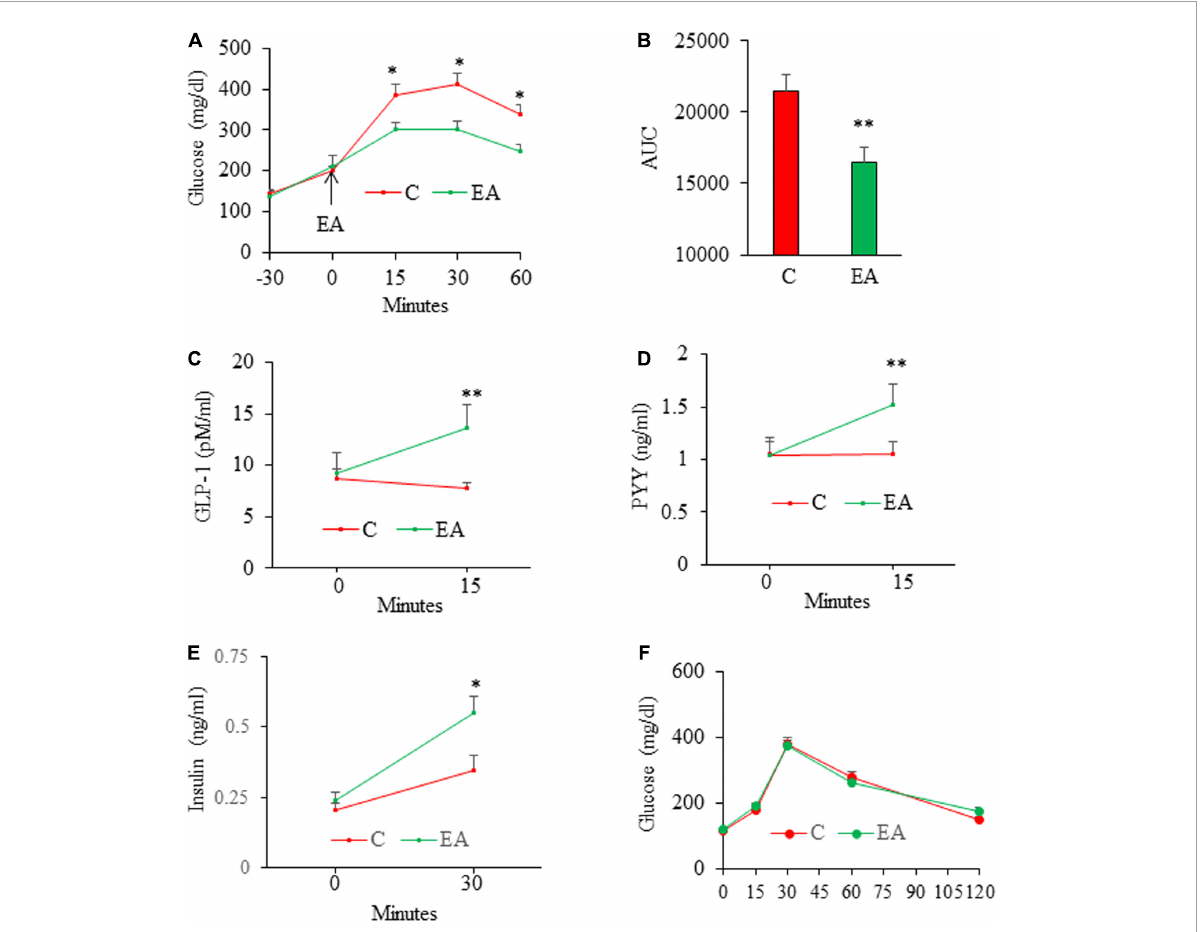
FIGURE3 Acute effects of elenolic acid (EA) on glucose tolerance, glucagon-like peptide-1 (GLP-1), peptide YY (PYY), and insulin secretion in mice. C57BL6 male mice (8 weeks old) on high-fat-diet (HFD) for 12 weeks were fasted for 14 h and then were given EA (50 mg/kg, oral gavage) or vehicle, followed by performing intraperitoneal glucose (1.5 g/kg) tolerance test (IGTT) (A) , and the area under the curve (AUC) from GTT was calculated (B) . For assessing the effects of EA on GLP-1 and PYY levels, obese mice were fasted for 6 h and blood was drawn for baseline analyses. Mice were then given EA (50 mg/kg) or vehicle. Blood total GLP-1 [tGLP-1, (C) ] and PYY (D) levels were measured at 15 min after gavage. (E) Plasma insulin levels in 6-h fasted mice before (0) and 30 min following sequential administration of EA (50 mg/kg, gavage) and by glucose (1.5 g/kg, ip. Injection). The results of IPGTT from lean (F) mice following administration of EA (50 mg/kg) via gavage. Data are mean ± SE. ∗ p < 0.05, ∗∗ p < 0.01 ( n = 4–8